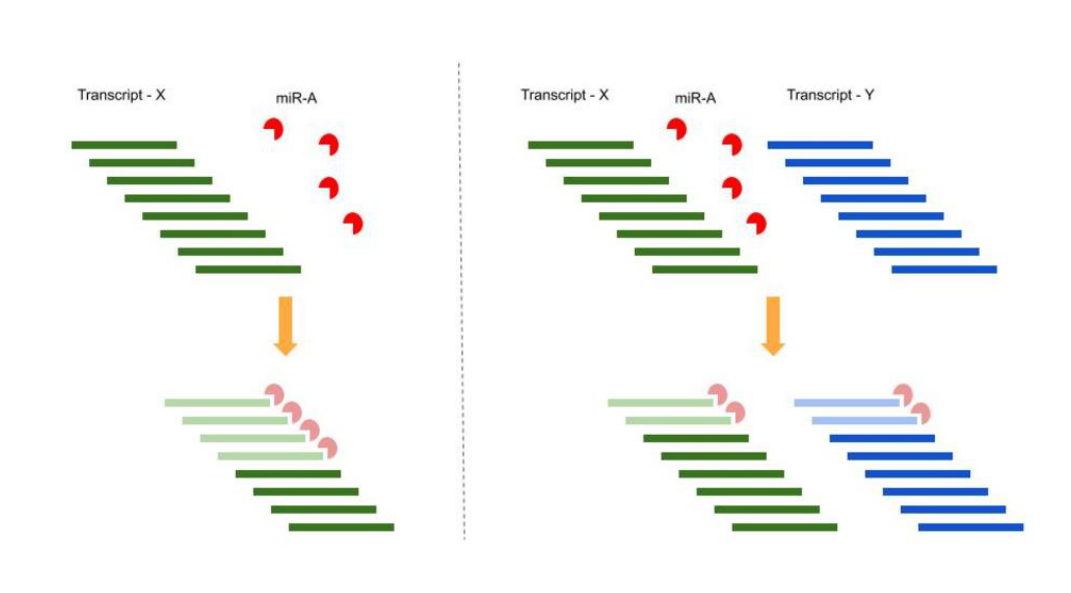
Figure 3. Top left panel : Before interaction, a naive situation with one miRNA: miR-A, and one target: transcript-X, in a 1:2 proportion ratio. Transcript-X harbors one miRNA response element (MRE) per molecule. Bottom left panel : After interaction, at the steady state, 50% of transcript-X molecules are under the miRNA repressive action (whether post-transcriptional degradation or translational repression) and 50% of transcript-X molecules are not affected by miR-A control. Top right panel : Before interaction, a new miR-A target is added: transcript-Y, in the same amount of transcript-X. Transcript-Y also has the same MRE per molecule. The new ratio between miR-A and transcript-X is 1:4. Bottom right panel : After interaction, at the steady state, miRNAs are shared in the same proportion between the two transcripts’ molecules. On average, 75% of transcript-X molecules are free from miRNA regulation without any changes in the transcriptional rate of